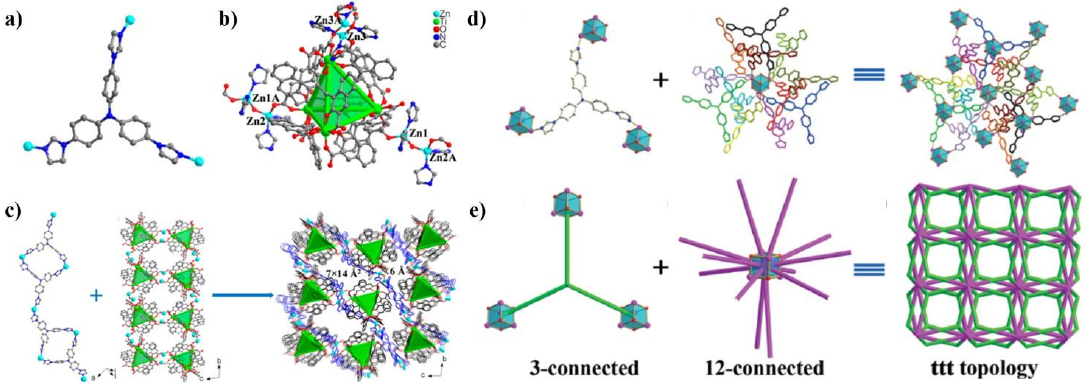
Figure 3. ( a ) Coordination environment of TIPA ligand. ( b ) Coordination model of the ZnII atoms, and Ti 4 L 6 cage in PTC-220. ( c ) Zn atoms linking the TIPA ligands into a chain. and Zn atoms linking the Ti 4 L 6 cages into a ladder-shaped chain, 3D framework of PTC-220 with different pore sizes. Reproduced with permission [75]. Copyright 2020, the American Chemical Society. ( d ) A 3-connected TIPA ligand and simplified 3-connected linker. ( e ) A 12-connected [Cd 4 ( µ 3 -OH) 4 ] cubic cluster and simplified 12-connected node, (3,12)-connected framework and the ttt topology. H atoms removed for clarity. Reproduced with permission [67]. Copyright 2014, Royal Society of Chemistry.